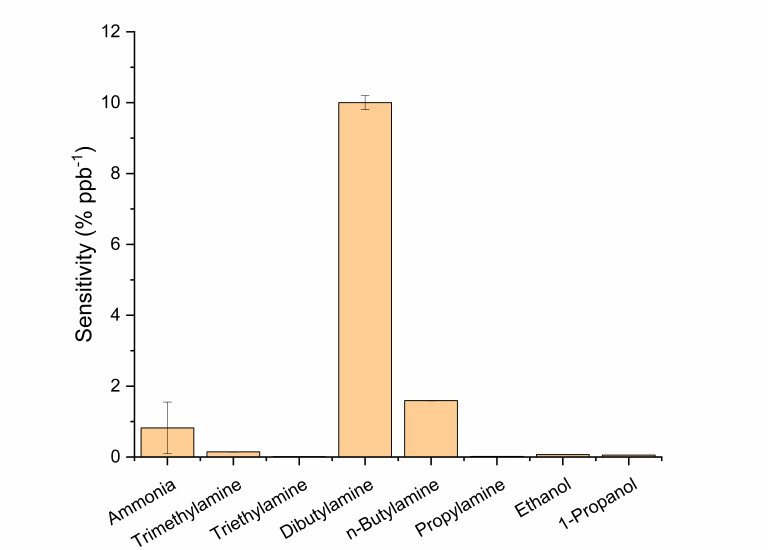
Figure 7. Plot of measured sensitivities of DPP-T-TT OSCs to different analytes, indicating high selectivity to the dibutylamine over the other analytes